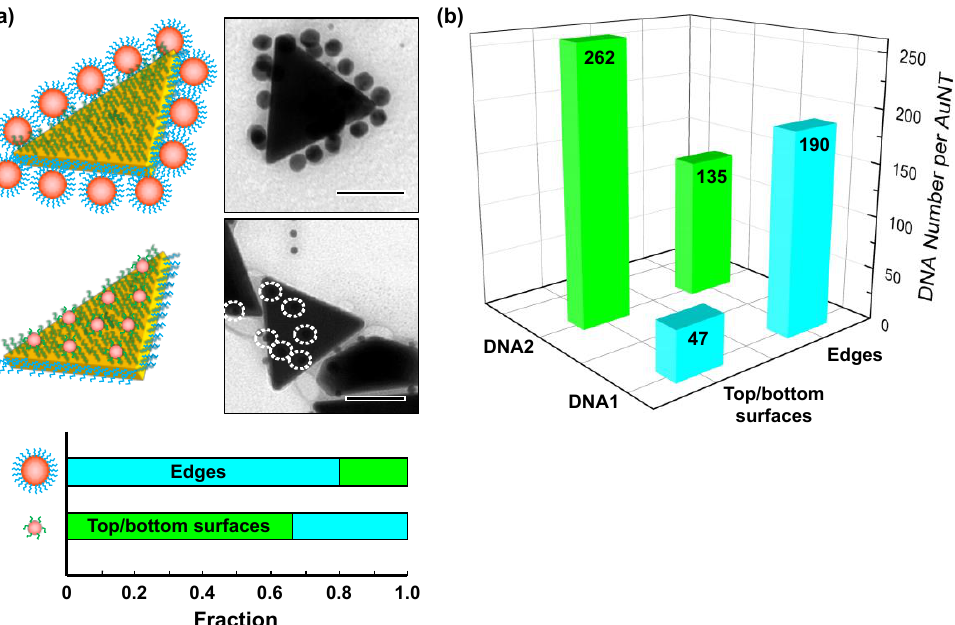
Figure 3. Characterization of the ssDNA-modified AuNTs. ( a ) Typical TEM images for the edge-attachment of 15 nm AuNSs (top) and for the flat surface-attachment of 5 nm AuNSs (bottom) to the AuNT. Scale bars are 50 nm. Degrees of regioselectivity in DNA modification on the AuNT surfaces are also shown. ( b ) The numbers of DNA1 and DNA2 grafted onto the edges and the top/bottom surfaces of a single AuNT.